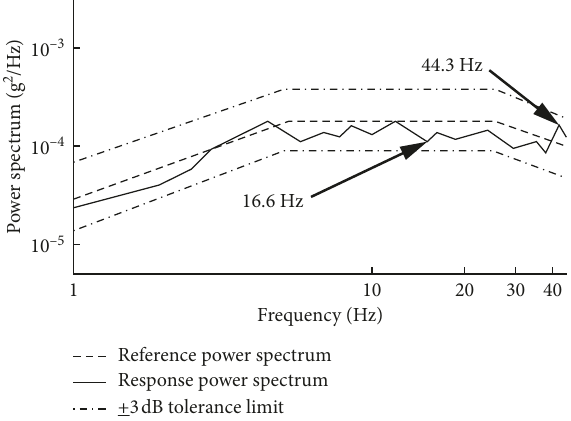
Figure 13: After resonant suppression by the multifrequency adaptive notch